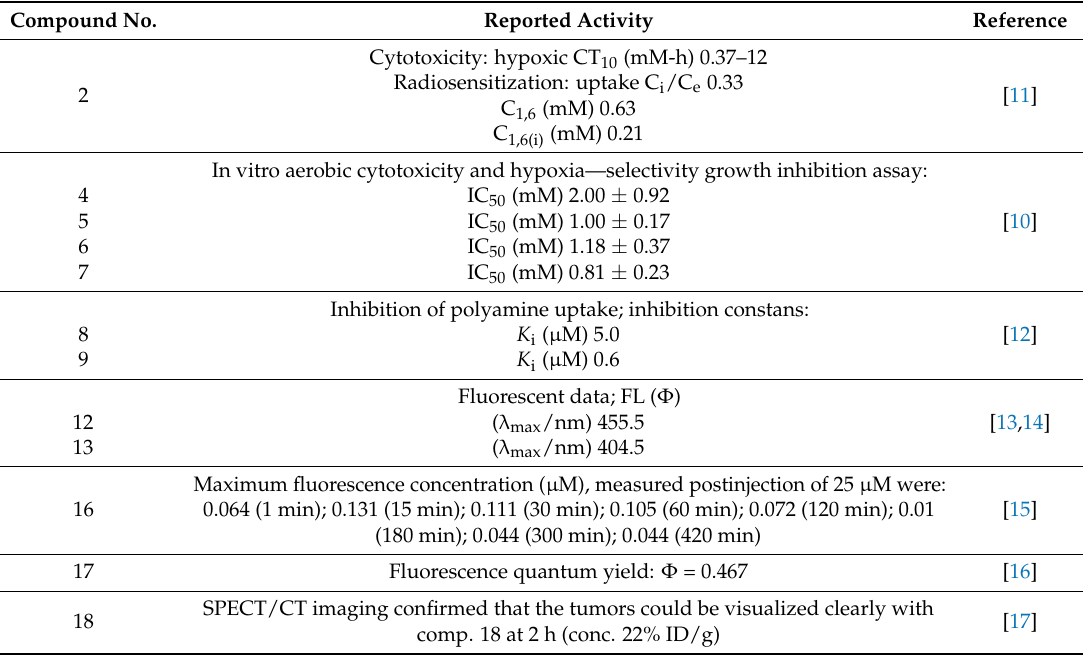
Table 1. The activities of presented double- and